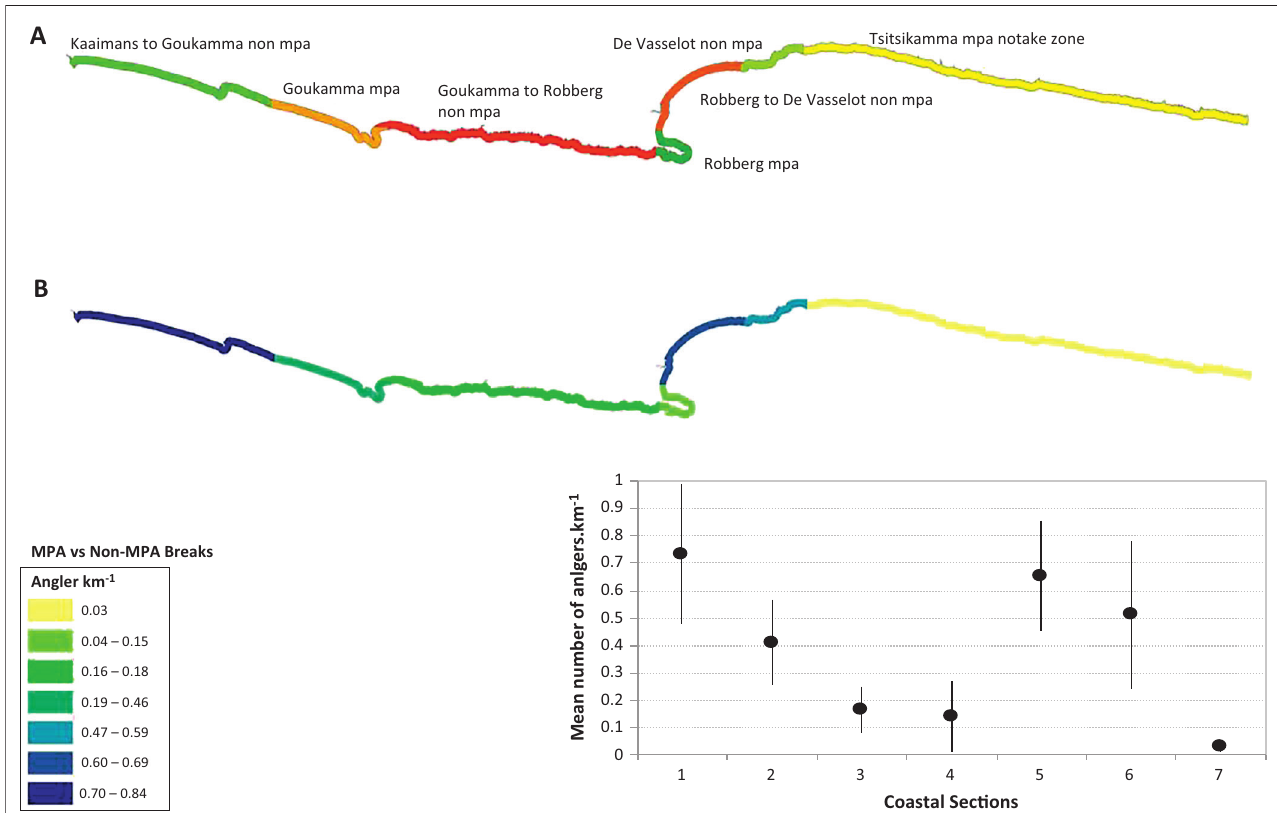
FIGURE 3: The South African Garden Route coastal section divided into marine protected areas and open areas (A) and the spatial distribution of total angling effort (anglers.km -1 ) within marine protected areas and open areas between the Kaaimans River in the west and the eastern border of the Tsitsikamma Marine Protected Area at the Groot River (B). Up–down bars indicate the 95 % confidence